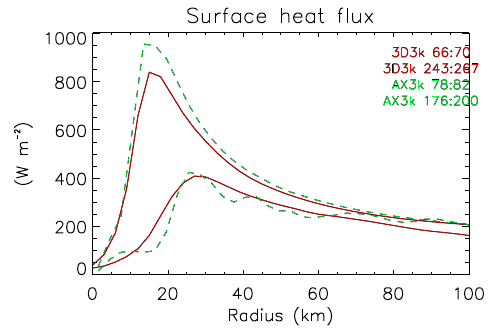
Fig. 4. Radial profile of surface enthalpy flux for the AX3k and 3D3k experiments at a time of maximum intensification rate (solid) and when the simulated hurricane has reached mature intensity (dashed).